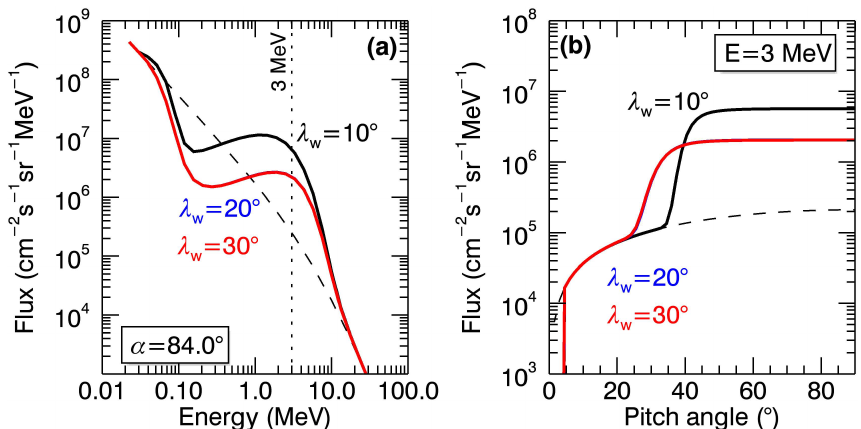
Fig. 7. Electron fluxes after 30 days using Galileo-based wave intensity extending to ± λ w . Please note the red and blue lines are overlapping. Dashed line shows initial condition.